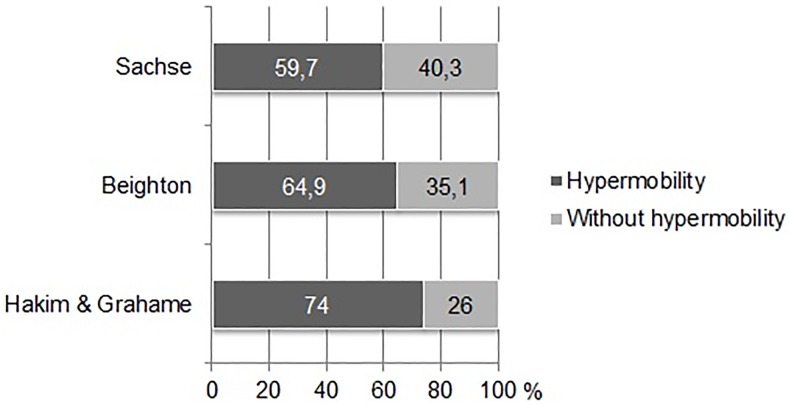
Percentage frequency distribution of JHS prevalence, according to Sachse, Beighton, and Hakim & Grahame.